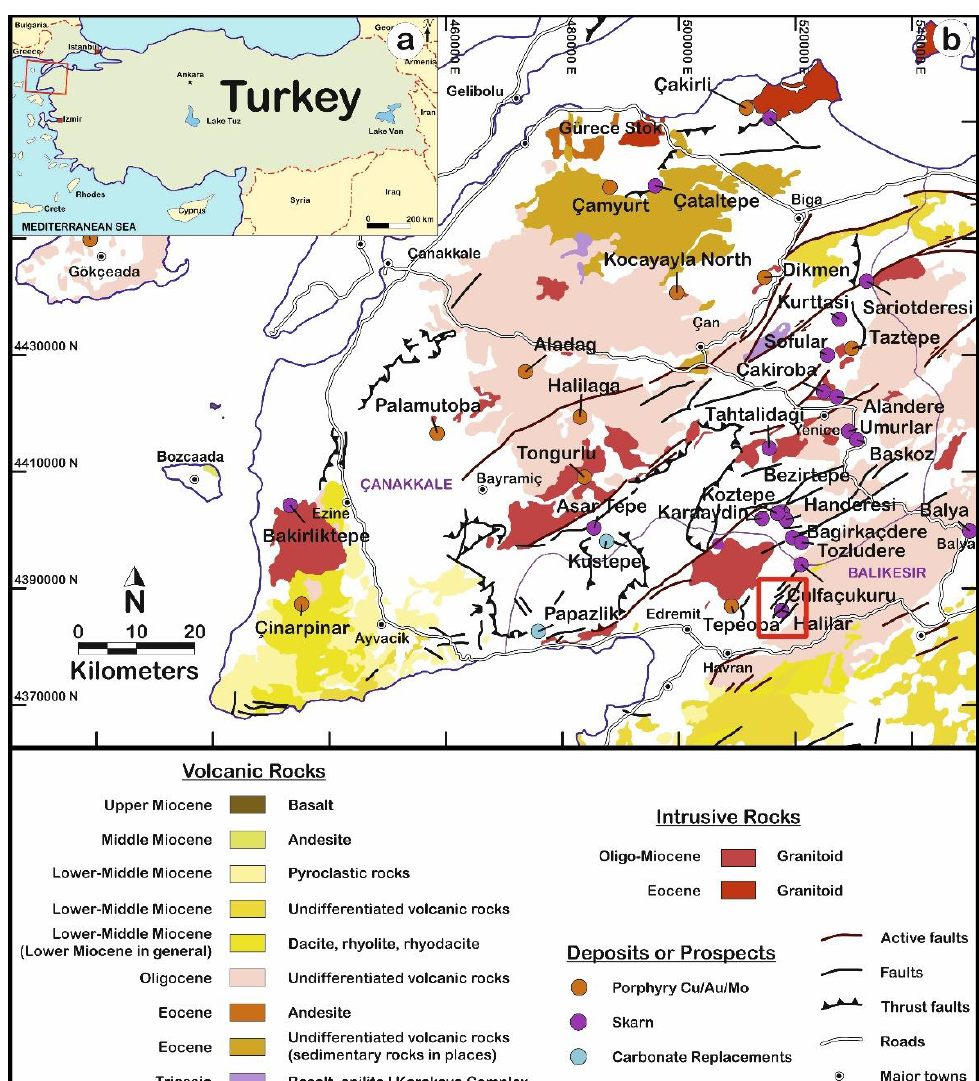
Figure 1. ( a ) Geological map of Turkey; ( b ) s tudy area around Halılar in the Northeast of Edremit in Balıkesir after Yigit